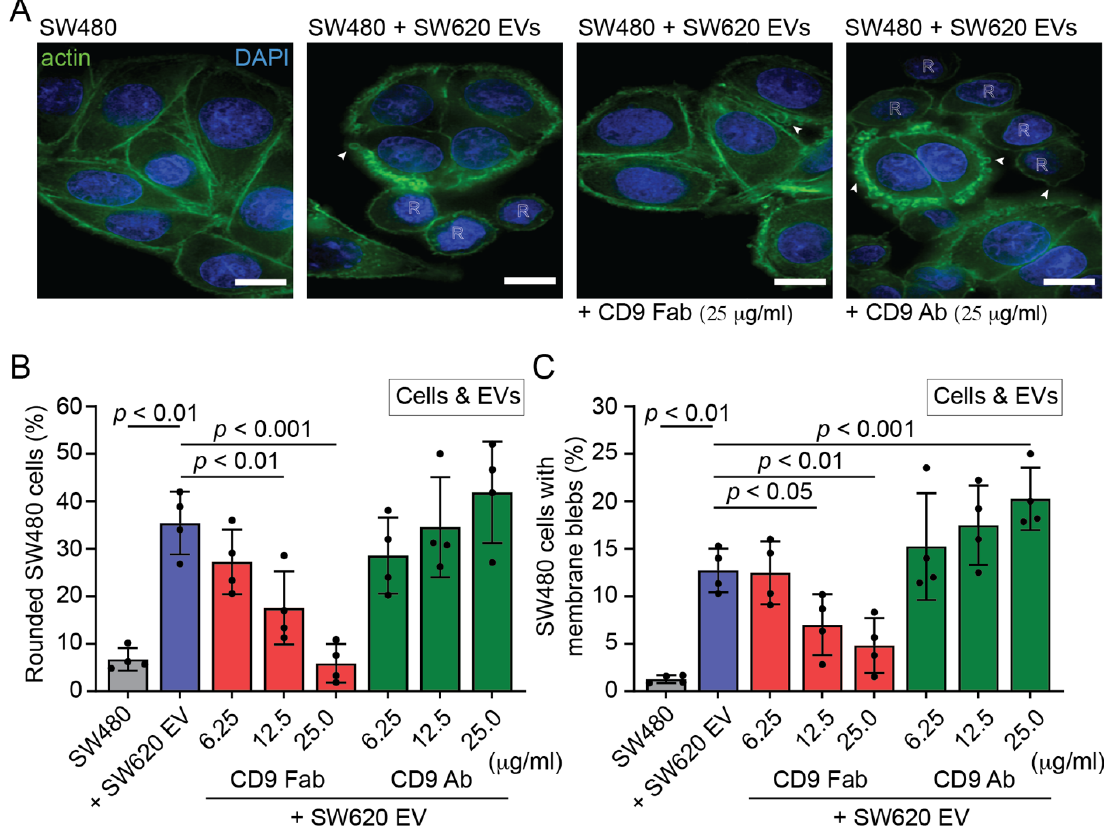
Figure 4. Effects of CD9 Fab and divalent Ab on the pro-metastatic morphological alterations of SW480 cells exposed to SW620 cell-derived EVs. ( A – C ) SW480 cells and SW620 cell-derived EVs (1 × 10 9 particles) were individually pre-incubated for 30 min with different concentrations of anti-CD9 Fab (red) or divalent Ab (green) as indicated before their co-incubation for 5 h in the presence of Abs, as described for protocol #1. As negative and positive controls, cells were not exposed (SW480, grey) or were exposed to EVs in the absence of Ab (+ SW620 EV, blue), respectively. Afterward, fixed cells were stained with DAPI and fluorochrome-conjugated phalloidin to label nuclei and actin filaments, respectively, before observation by CLSM ( A ). Single sections are presented. Rounded cell morphology and membrane blebs induced by EVs are indicated by the letter R and the arrowheads, respectively. The percentage of cells with rounded morphology ( B ) or membrane blebs ( C ) was quantified. Means ± S.D. and individual values for each experiment are shown ( n = 4). At least 100 cells were evaluated for each experiment. p values are indicated. Similar experiments were performed by pre-incubating only EVs or cells with Abs (Supplementary Figure S5). Scale bars, 10 μm.